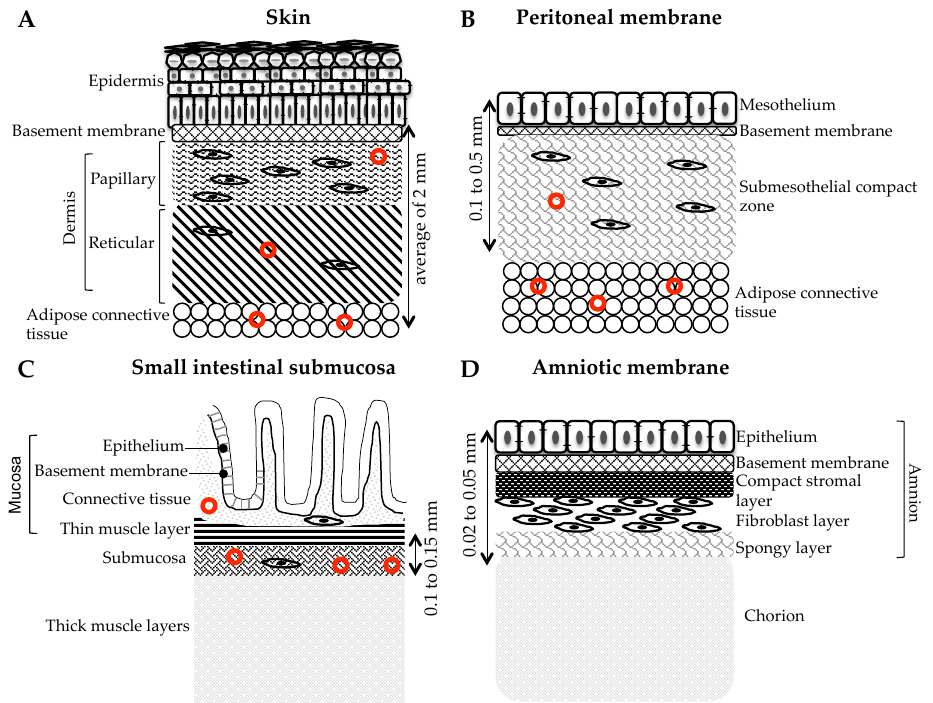
Figure 2. Detailed schematic histological representation of tissues used for decellularization for skin repair and regeneration. The various tissue compartments of skin ( A ), peritoneal membrane ( B ), small intestinal mucosa ( C ) and amniotic membrane ( D ) are represented by separate graphics and annotated on the side. When a tissue compartment is cellularized, cells are drawn in black and when it is vascularized, vessels are represented by red circles. The tissue layers used for decellularization and clinical applications are shown by arrows on the side indicating their average